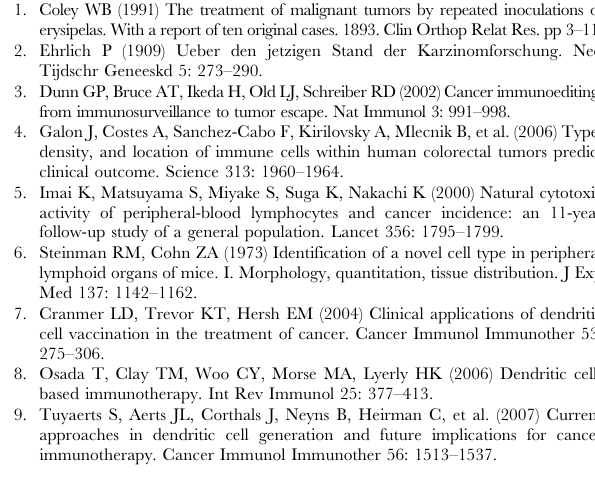
Figure S1 Forest plots of Mantel-Haenszel odds ratio estimates. Meta-analysis of the odds ratio of cellular immune response (A, B) or total DC dose (C, D) and clinical benefit rate for prostate cancer and RCC trials are displayed. The size of the squares is proportional to the sample size. Horizontal lines denote 95% confidence intervals for single studies, the diamond the 95% confidence interval for the overall Mantel-Haenszel estimate (fixed effect). (TIFF) Table S1 Additional information about included pa- tients, clinical response criteria and clinical responses. (PDF) Table S2 Additional information about number of DC per vaccination and number of vaccinations. Table S3 Additional information about toxicity criteria and observed toxicity. Table S4 Detailed information about humoral and cellular immune response testing within the trials. Table S5 Additional information about data extraction for individual patient data level